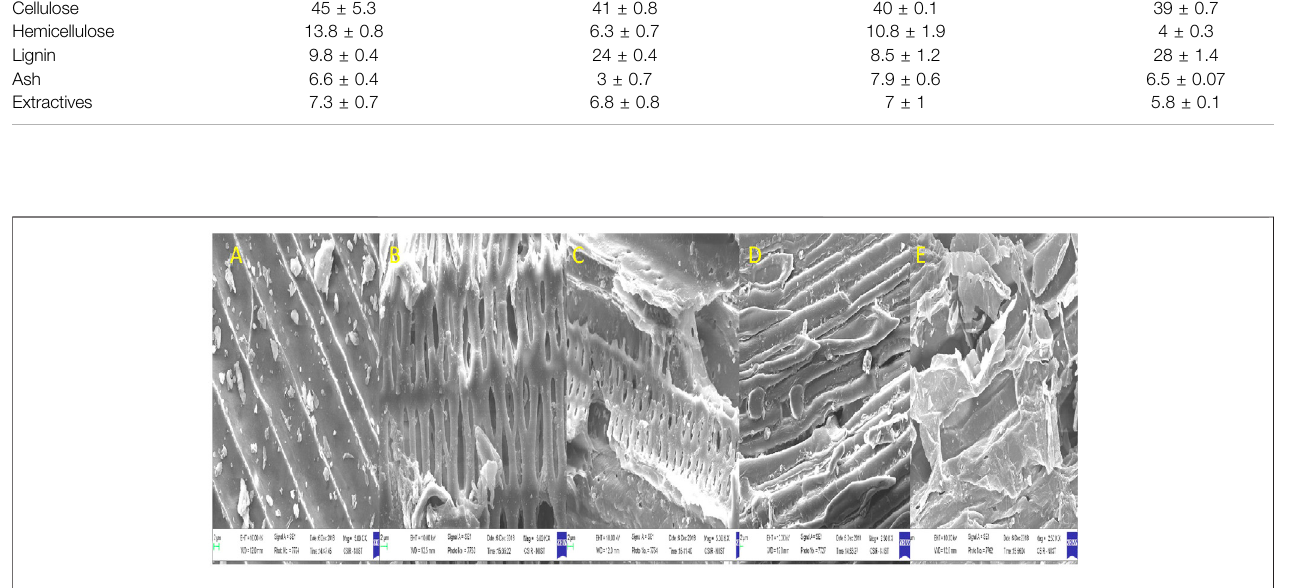
FIGURE 1 | Scanning electron microscopic images of pretreated biomass. Legends: (A) native, (B) sono-alkali Chilika Lake, (C) sono-alkali Loktak Lake, (D) acid Chilika Lake, and (E) acid Loktak